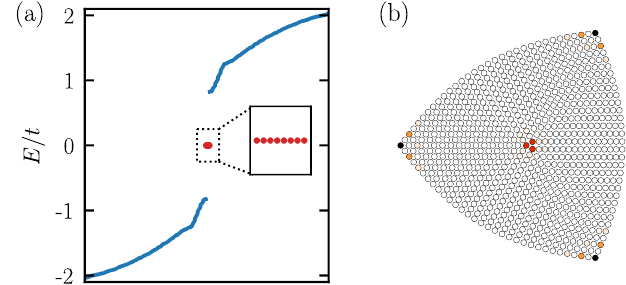
Figure 14: Model of a 2D second-order topological superconductor in class DIII on a square lattice with disclination as defined in Eq. (15): the model parameters are δ t = − 0.5 t , λ = 0.5 t . (a) Low-energy spectrum with four Kramers pairs of Majorana zero modes highlighted in red. (b) Real-space weights of the Majorana zero